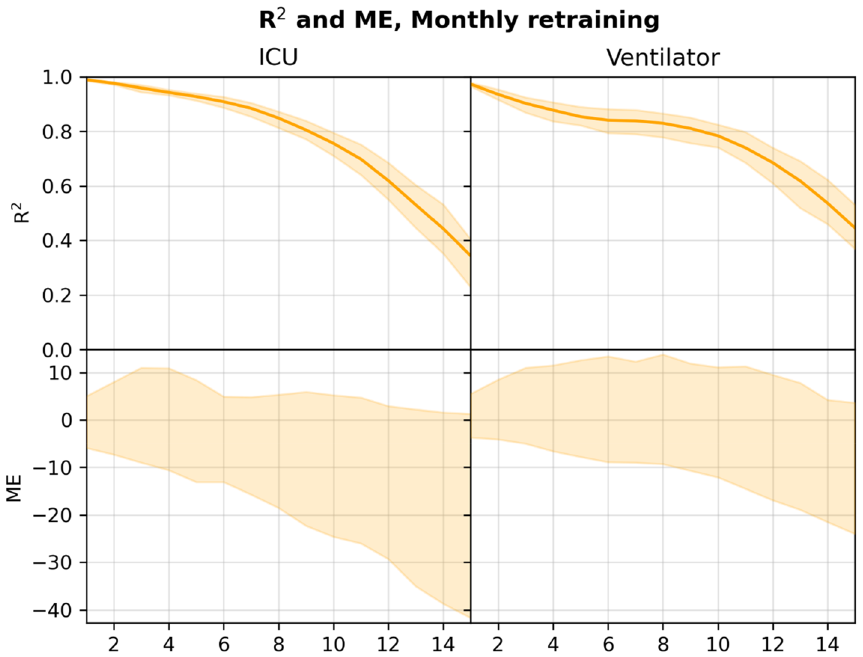
Figure 2. R 2 and 95% confidence interval (top), and ME (bottom) for n -day forecasts using the RF model in the monthly retrained setting, computed on the pooled predictions for the months after June 2020. Numerical results are given in Supplementary Tables 3 and